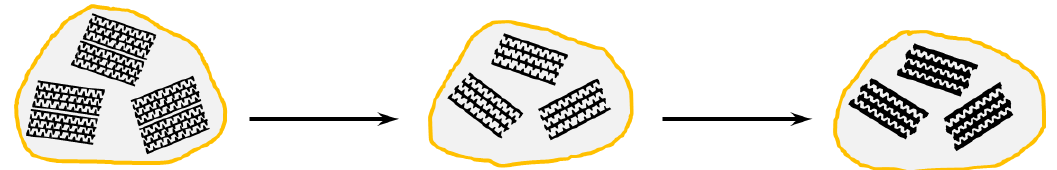
Figure 16. SEM images of reduced CVTP with Co 2 O 3 additions: ( a ) 0 wt %, ( b ) 2 wt %, ( c ) 4 wt %, and ( d ) 6 wt %.